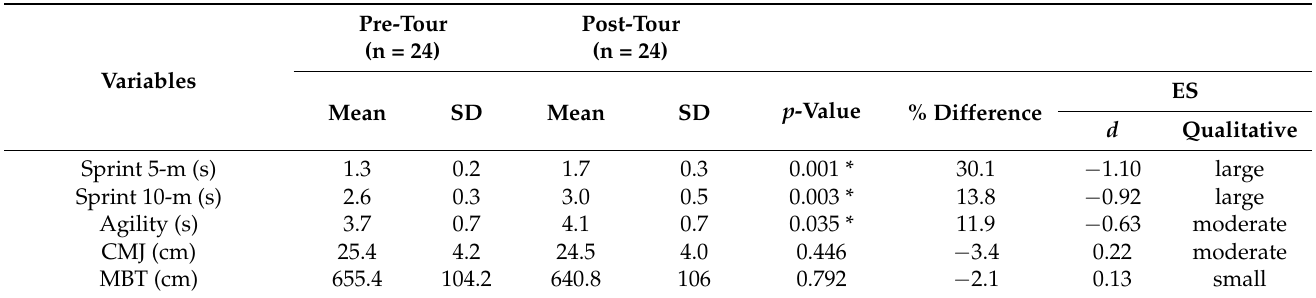
Table 2. Pre- and post-tour physical performance tests.